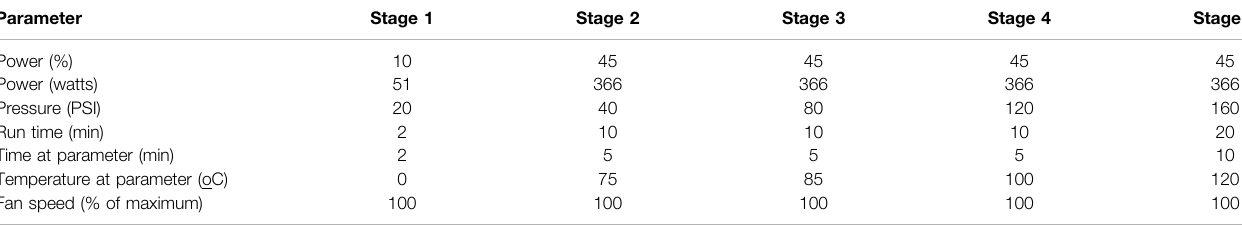
TABLE 3 | Quanti fi cation of heavy metals observed in selected phytopigments with prescribed limits. Sl. no